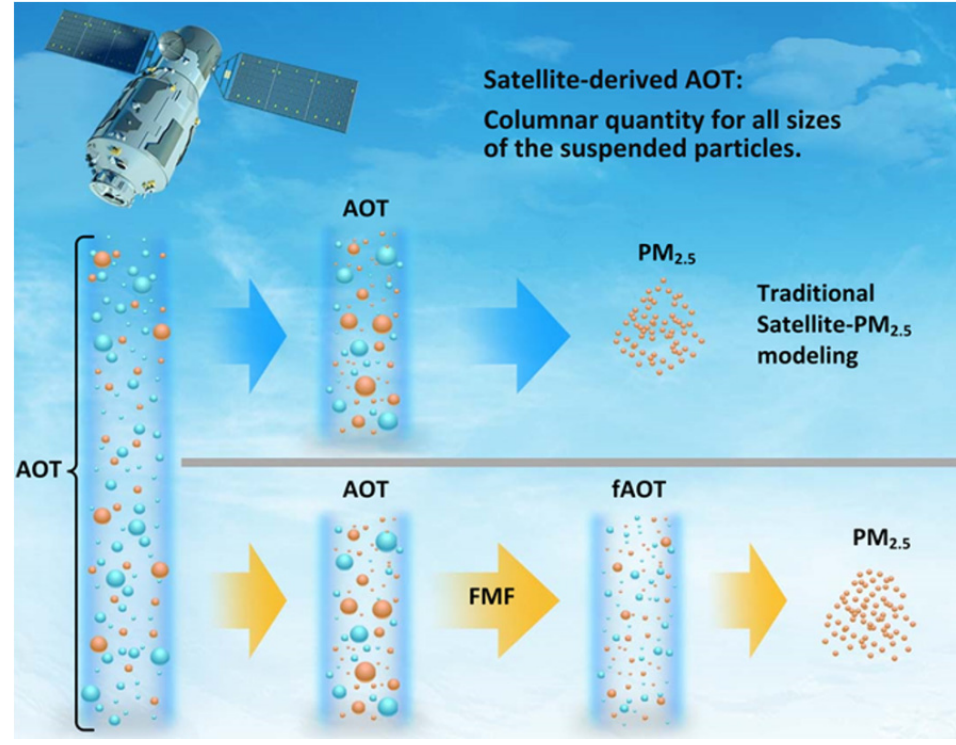
Figure 1. Schematic diagram showing traditional AOT-based and new fAOT-based PM 2.5 modeling based on satellite data.